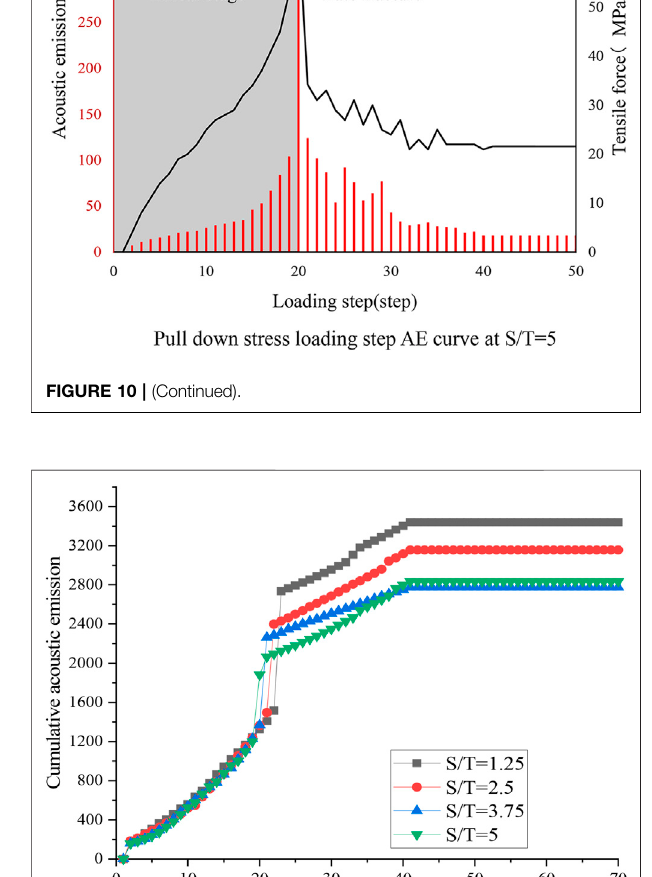
FIGURE 11 | Cumulative AE under four S/T